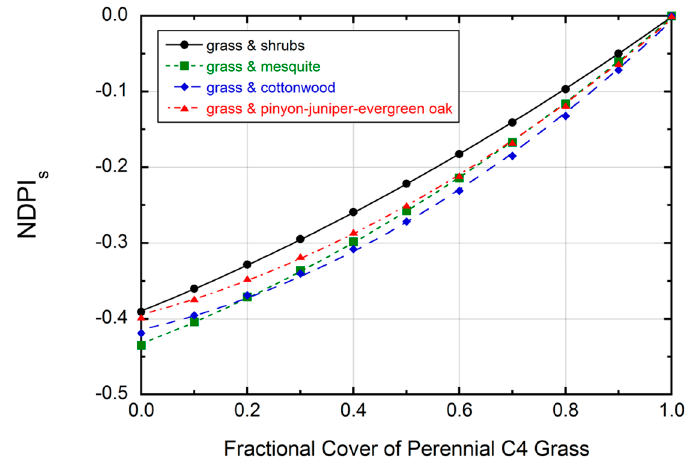
Figure 9. Results from linear mixture modeling of the response of NDPI s to subpixel variation in fractional cover of perennial C 4 grass in theoretical combinations with shrubs, mesquite, riparian cottonwood, and pinyon-juniper-evergreen oak. R 2 values ( p < 0.001) from 2nd-order polynomial least-squares regression are 0.99 (grass and shrubs, grass and mesquite), 0.97 (grass and cottonwood), and 0.98 (grass and pinyon-juniper-evergreen oak).